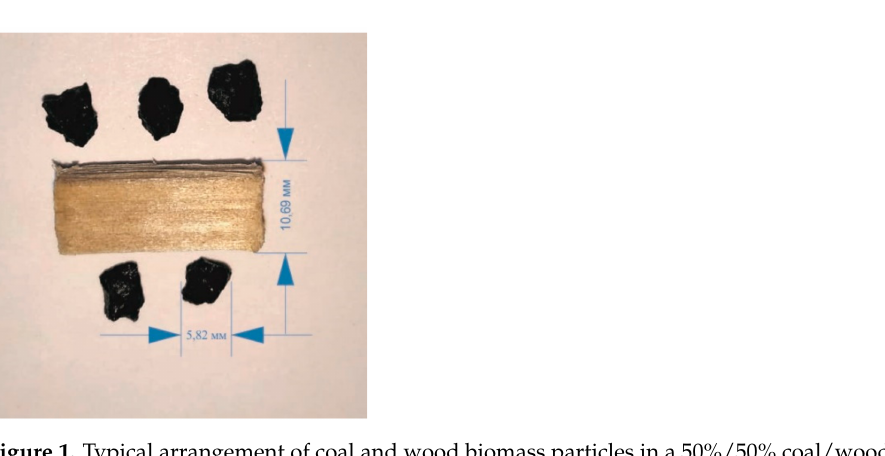
Figure 1. Typical arrangement of coal and wood biomass particles in a 50%/50% coal/wood compo- nent ratio.